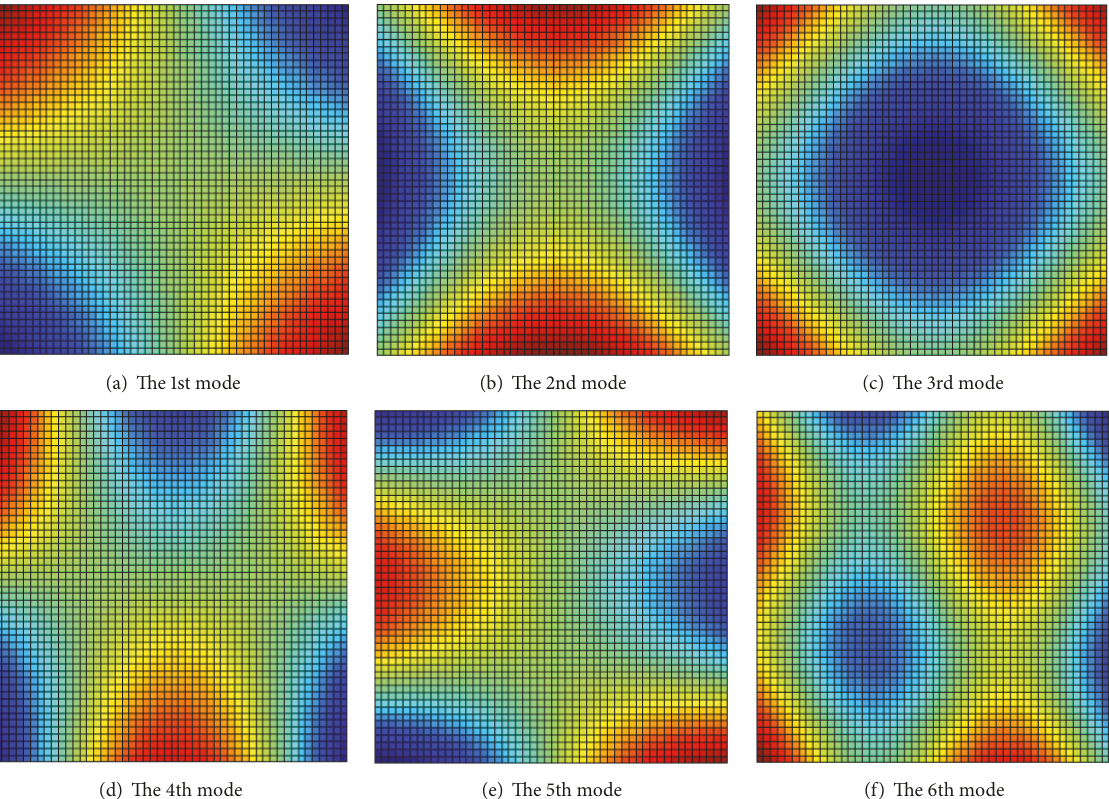
Figure 3: The first six mode shapes of square rectangular plates with completely free boundary conditions calculated by the present method. Table 2: Frequency parameters Ω = 𝜔𝑏 2 (𝜌ℎ/𝐷) 1/2 /𝜋 2 for the square plate of case 1 with restraining stiffness, 𝜉 𝑘 each point support. 𝑅 ,